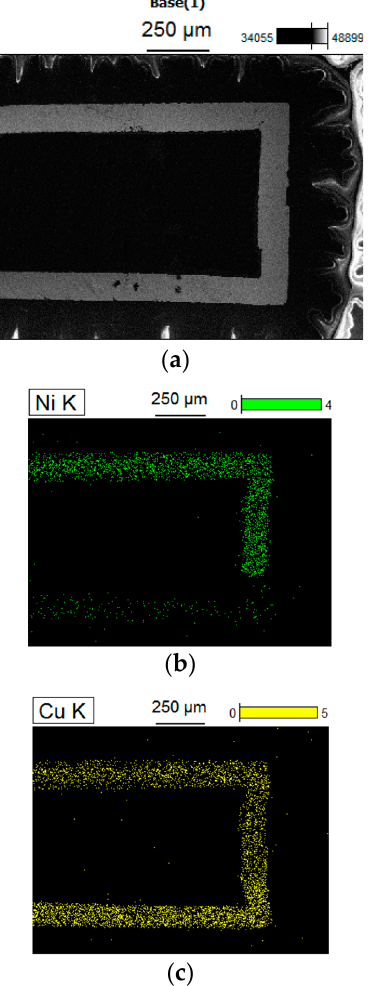
Figure 11. Fabrication-process diagram of the sensor.